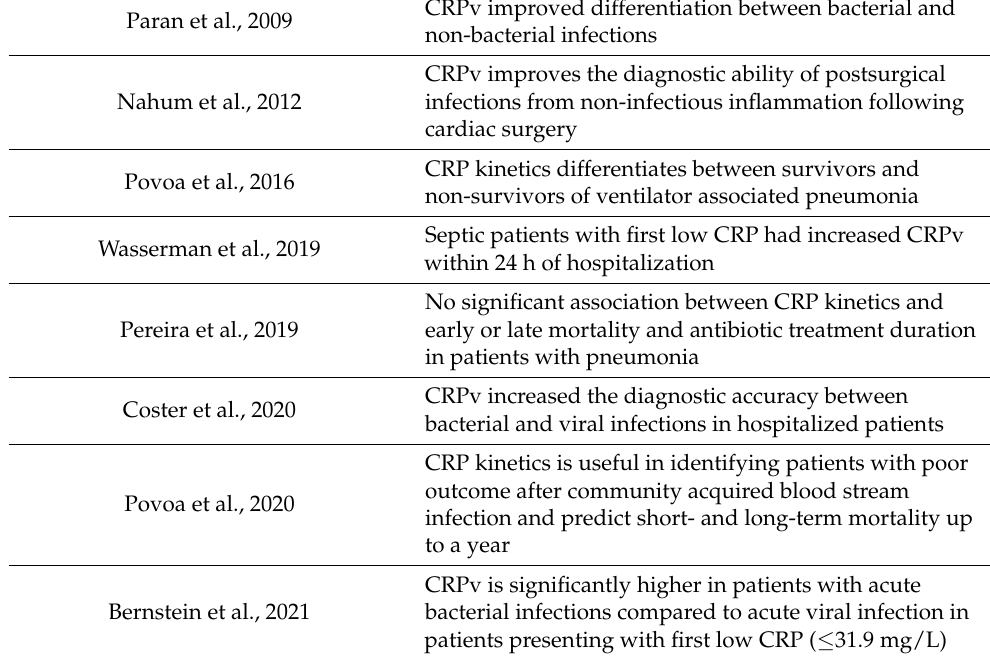
Table 1. CRP velocity in infectious disorders. CRPv improved differentiation between bacterial and Paran et al., 2009 non-bacterial infections CRPv improves the diagnostic ability of postsurgical Nahum et al., 2012 infections from non-infectious inflammation following cardiac surgery CRP kinetics differentiates between survivors and Povoa et al., 2016 non-survivors of ventilator associated pneumonia Septic patients with first low CRP had increased CRPv Wasserman et al., 2019 within 24 h of hospitalization No significant association between CRP kinetics and Pereira et al., 2019 early or late mortality and antibiotic treatment duration in patients with pneumonia CRPv increased the diagnostic accuracy between Coster et al., 2020 bacterial and viral infections in hospitalized patients CRP kinetics is useful in identifying patients with poor outcome after community acquired blood stream Povoa et al., 2020 infection and predict short- and long-term mortality up to a year CRPv is significantly higher in patients with acute Bernstein et al., 2021 bacterial infections compared to acute viral infection in patients presenting with first low CRP ( ≤ 31.9